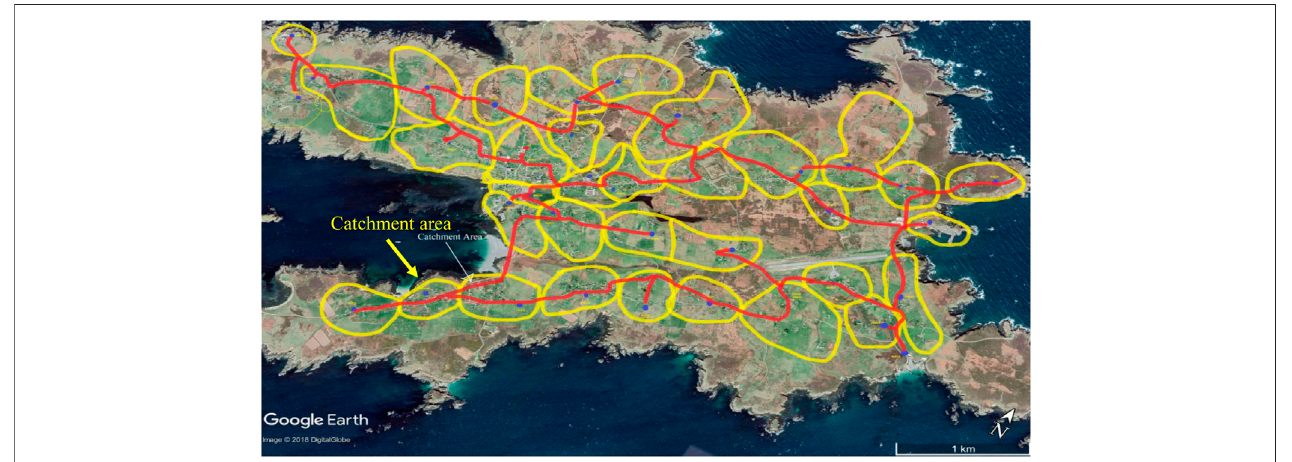
FIGURE 8 | Ushant schematic power network